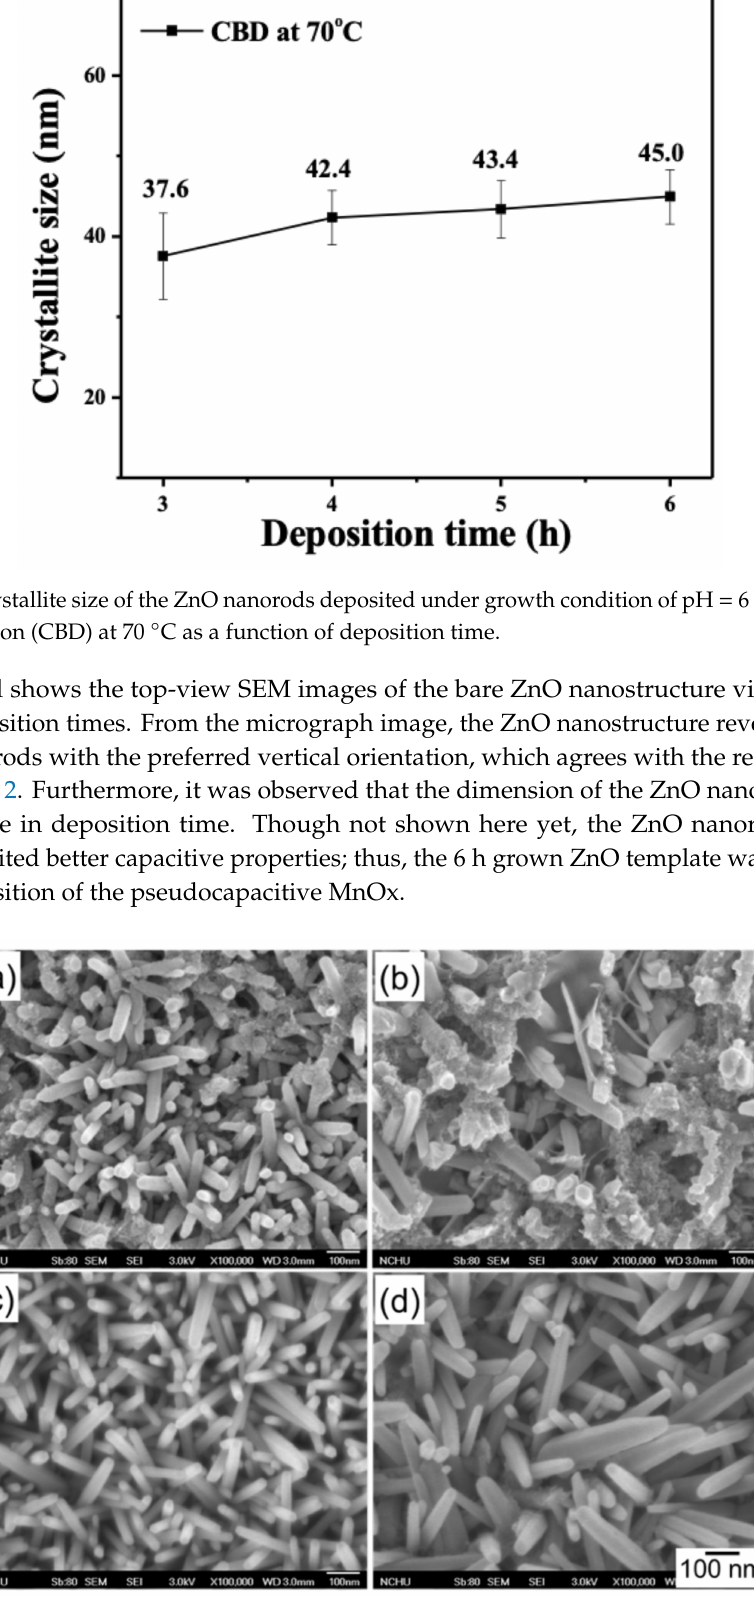
Figure 4. Scanning electron microscopy (SEM) micrographs of the ZnO nanorods deposited under growth condition of pH = 6 by CBD at 70 ◦ C for deposition times of ( a ) 3, ( b ) 4, ( c ) 5, and ( d ) 6